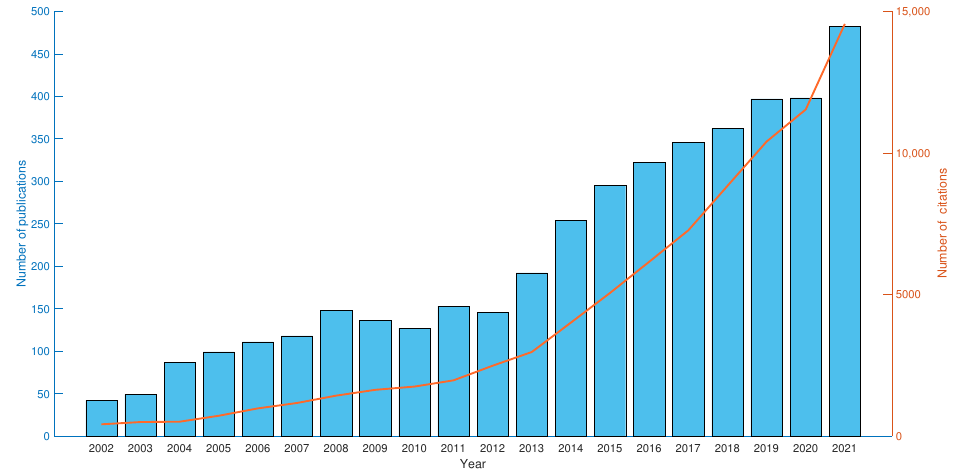
Figure 2. The development trend of SC in the past two decades.